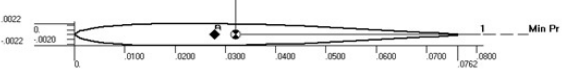
Figure 2. NACA 0006, shear center